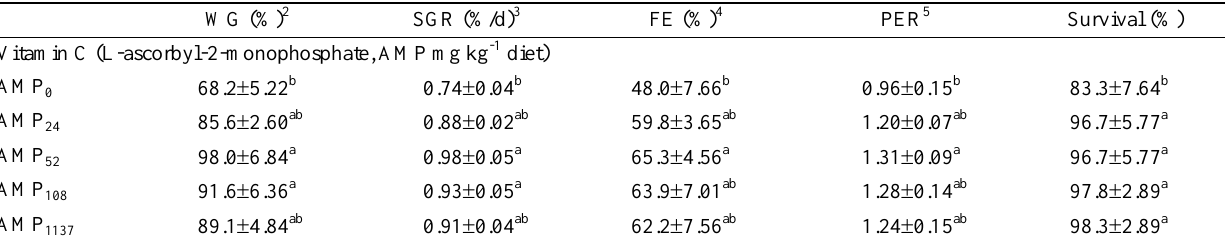
1 Values are means from triplicate groups of fish where the means in each column with a different superscript are significantly different (p<0.05). 2 Weight gain (%) = ((final wt. -initial wt.)/initial wt.) × 100. 3 Specific growth rate (%) = ((log